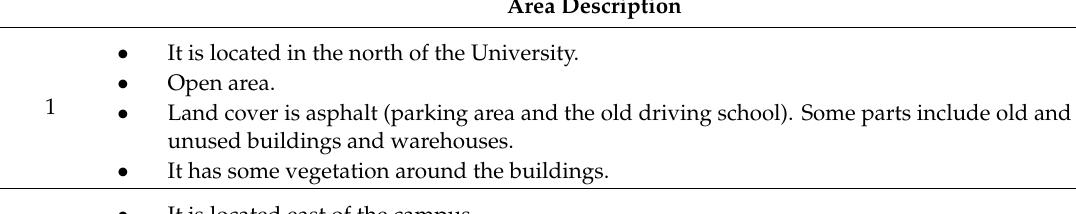
Table A1. Description of KAU sites, as presented in Figure